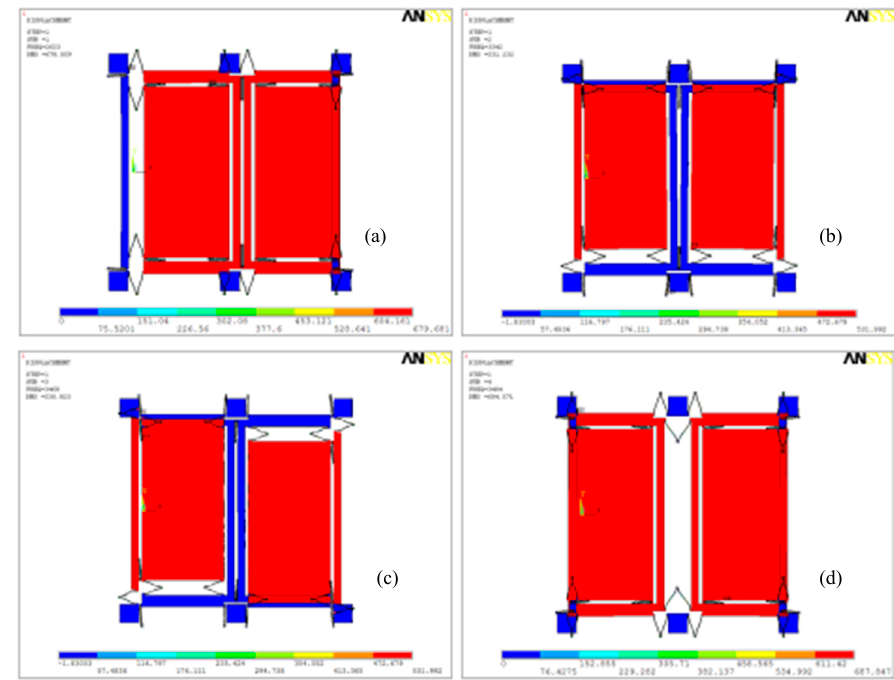
Figure 2. ( a ) The first mode: drive in phase mode ω x 1 = 2623 × 2 π rad/s; ( b ) The second mode: sense in phase mode ω y 1 = 3342 × 2 π rad/s; ( c ) The third mode: sense anti-phase mode ω y 2 = − 3468 × 2 π rad/s; and ( d ) The fourth mode: drive anti-phase mode ω x 2 = 3484 × 2 π rad s⁄ .